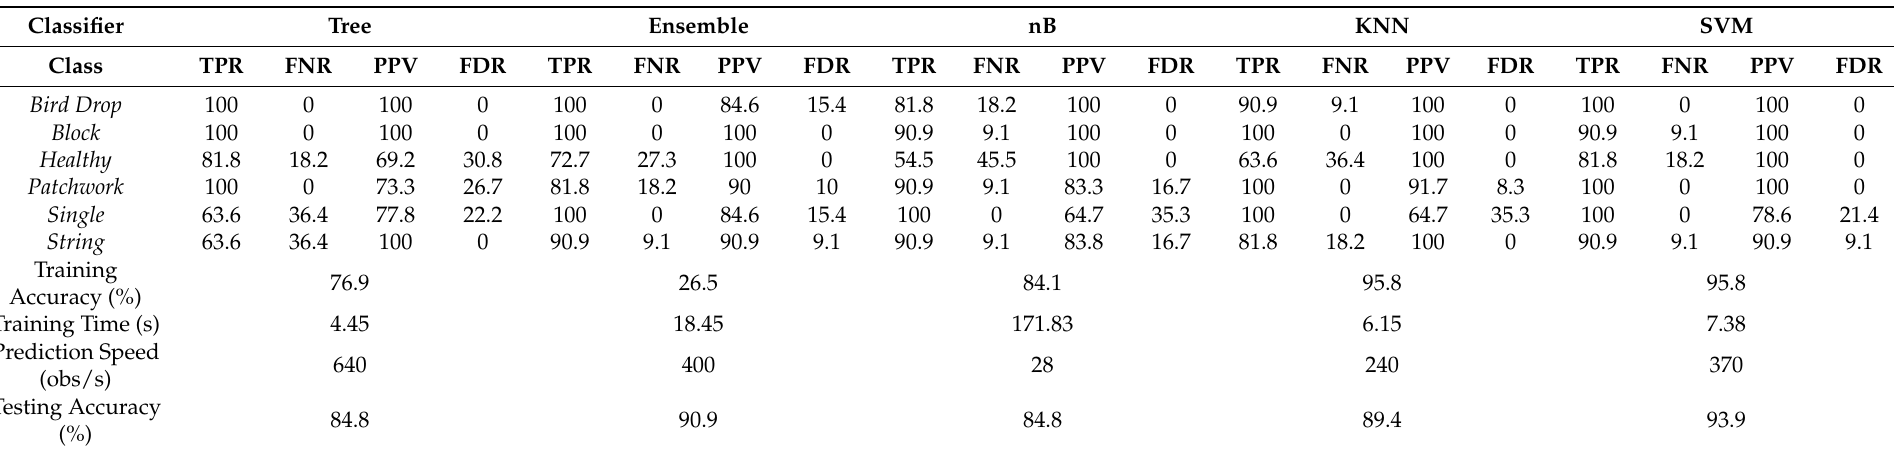
Table 7. SqueezeNet-based features calculation and shallow